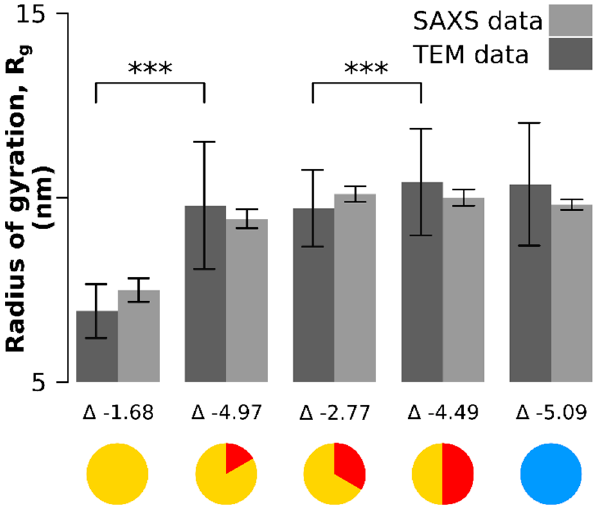
Figure 3. Comparison of the radii of gyration between SAXS and TEM measurements (model-free data). The lower bound 95% confidence interval of the di ff erence between the means (denoted as ∆ ) is always negative, which means there is no significant di ff erences between the SAXS and TEM measurements. Significant di ff erences between time points in radius of gyration were observed between the onset time point and the 10 min time point and between the 20 min and 30 min time point. The larger error in the TEM-based quantification originates from smaller sample sizes and a di ff erent counting mode (TEM counting and SAXS fit). *** means p < 0.001.